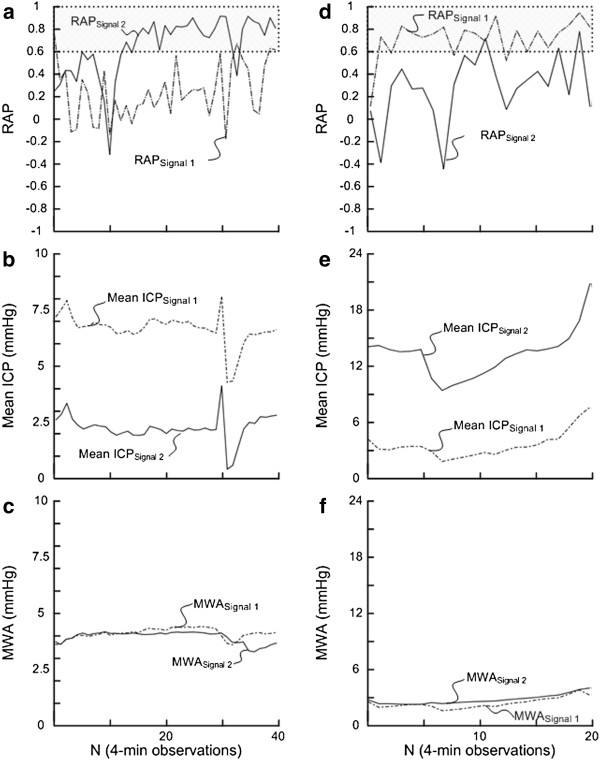
Trend plots of RAP, mean ICP and MWA of Signals 1 and 2 in patients 1 and 20. For patient 1 the trend plots of (a) RAP determined during consecutive 4-min periods for Signal 1 and 2 show marked differences (average of RAPSignal 1 0.22; average of RAPSignal 2 0.63), accompanied with marked differences in (b) mean ICP (average of mean ICPSignal 1 6.6 mmHg; average of mean ICPSignal 2 2.2 mmHg) while minor differences in (c) MWA (average of MWASignal 1 4.0 mmHg; average of MWASignal 2 3.9 mmHg). Similarly, for patient 20 the trend plots of (d) RAP revealed marked differences (average of RAPSignal 1 0.72; average of RAPSignal 2 0.29), and markedly different (e) mean ICP (average of mean ICPSignal 1 3.5 mmHg; average of mean ICPSignal 2 13.2 mmHg) despite similar (f) MWA (average of MWASignal 1 2.4 mmHg; average of MWASignal 2 2.8 mmHg). The horizontal lines at RAP 0.6 illustrate a commonly used upper normal threshold for RAP.